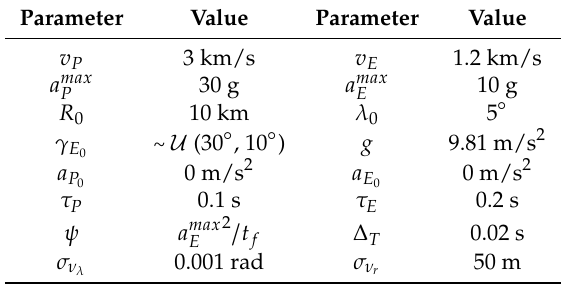
Table 1. Simulation initial values and